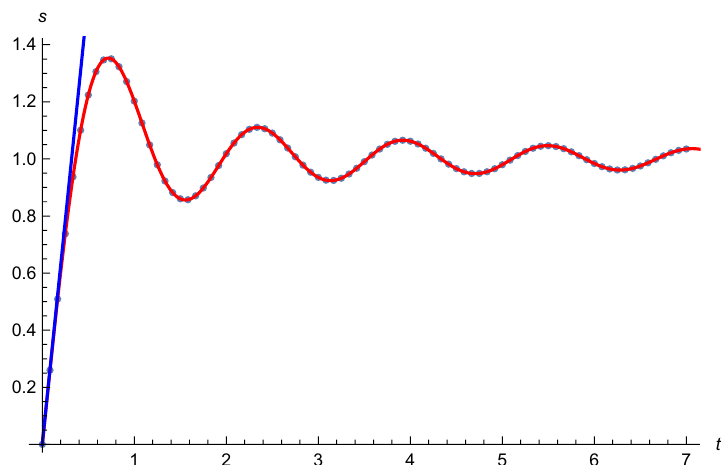
Figure 4. Plot of s ( (cid:12) = 0 ; t ) in the small t region. The dots are the exact values of s (0 ; t ) for N = 500. The blue line is the (cid:12)rst term s = (cid:25)t in the Taylor expansion of s (0 ; t ) in (5.3), while the red curve represents the Bessel function in (5.5). This (cid:12)gure is a closeup of the small t region of (cid:12)gure